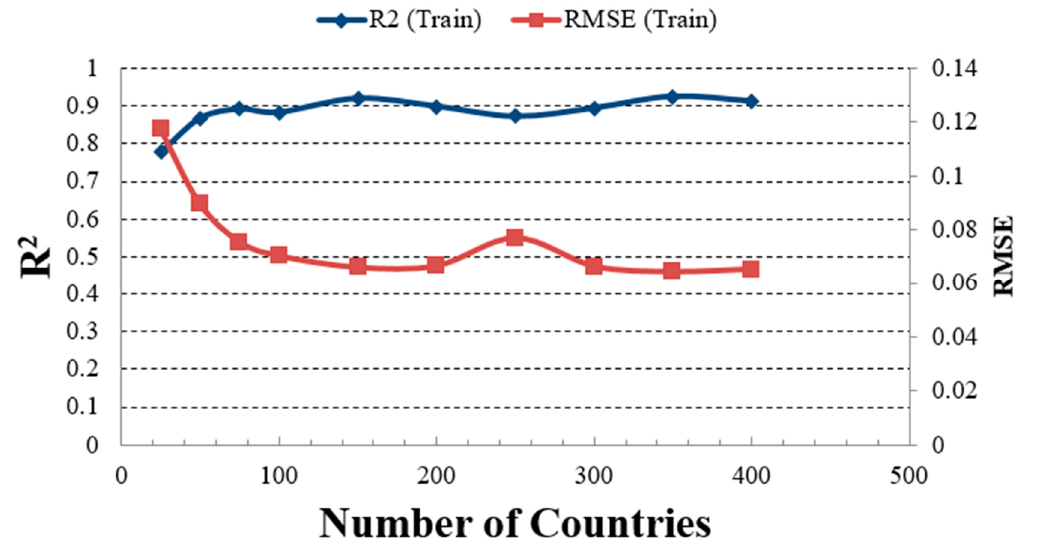
Figure 7. Performance indices (PIs) Changes for training section.